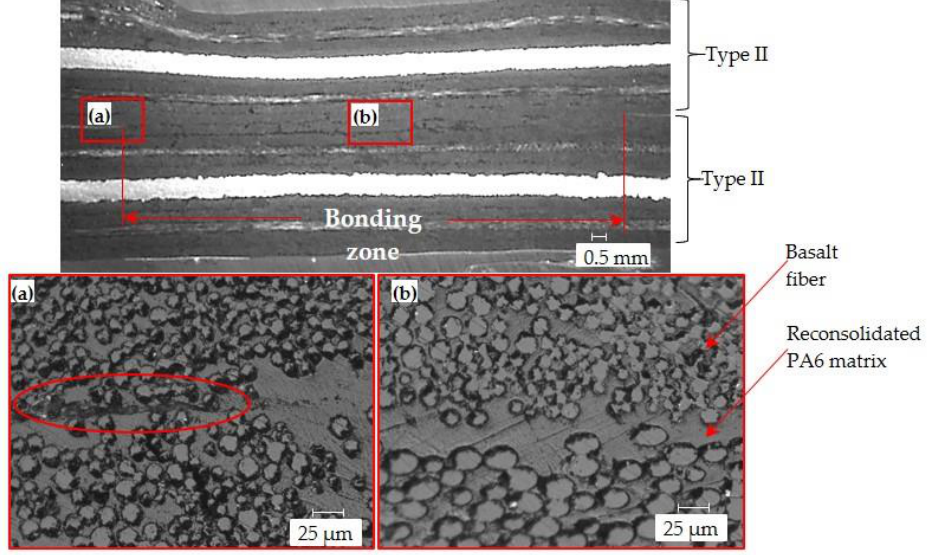
Figure 11. Joined sample of II+II showing the bonding zone length. ( a ) start of the bonding zone and ( b ) consolidation of the PA6 matrix between the two laminates.